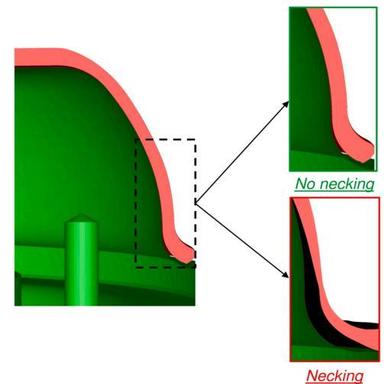
Flow formed wall of a necking configuration compared with a "safe" configuration (experimental results).